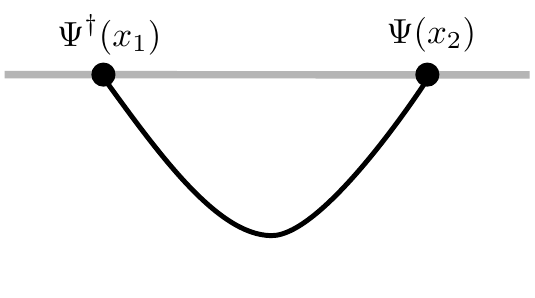
Figure 4: Computing two-point function of Ψ holographically: as the bulk charged worldline cannot break, the answer always depends strongly on separation between